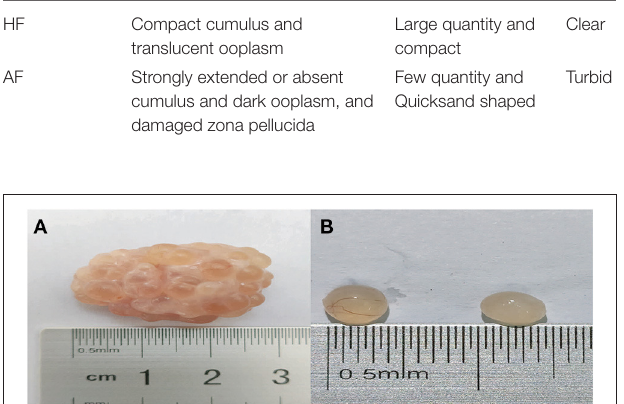
FIGURE 1 | The morphologies of the ovary and follicles of Bama Xiang pig. (A) The right ovary of the Bama Xiang pig. (B) The healthy follicle (left side) and atretic follicle (right side) in the same ovary of Bama Xiang pig.